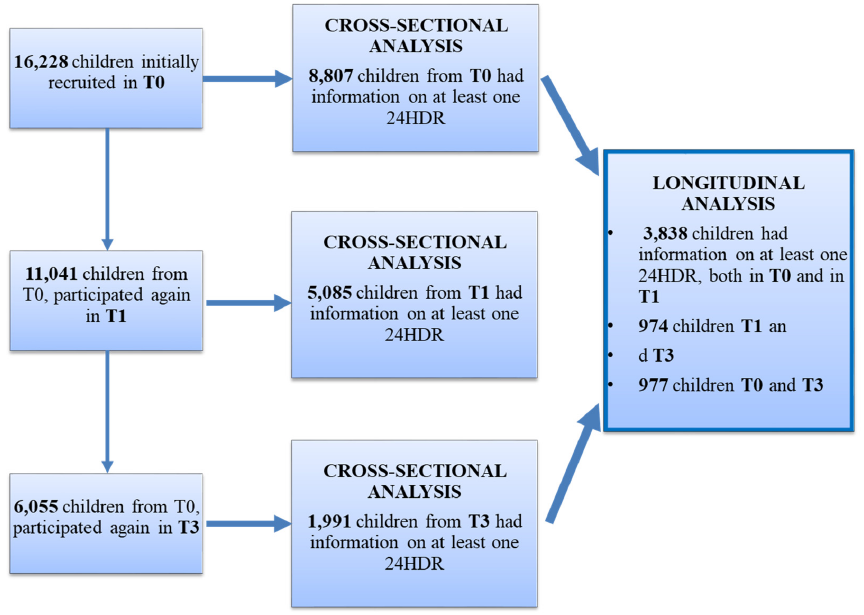
Figure 1. Flow chart of the sampling.